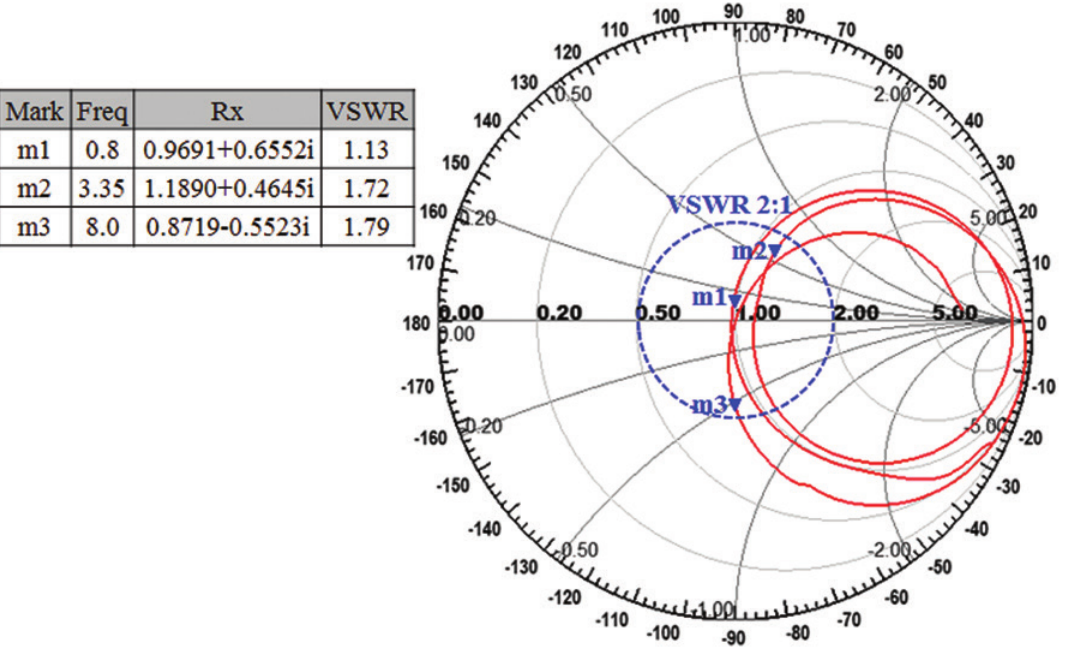
Figure 7: Simulated Smith chart presentation of the proposed multiband planar antenna.